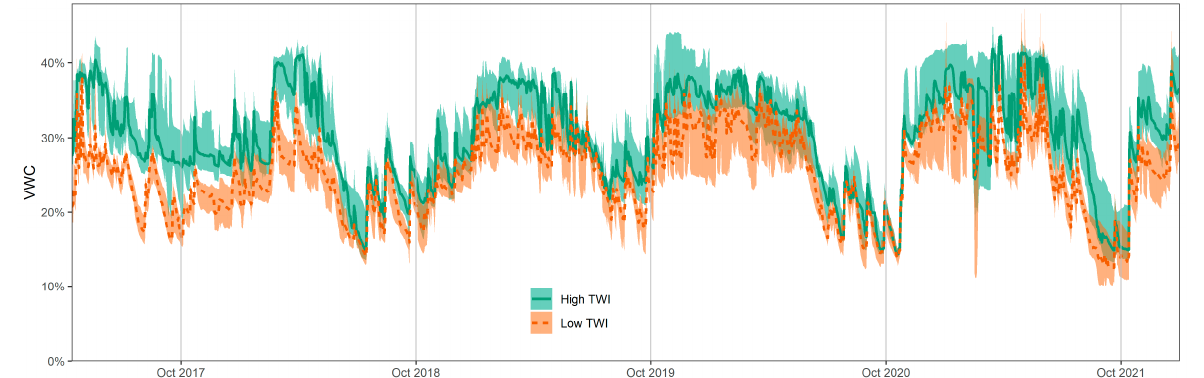
Figure 4. Daily median soil moisture values at 15 cm. Shaded regions represent the 25th and 75th percentile soil moisture values and illustrate spatial variability at each timestep. Green line represents the median value of VWC for the sensors in locations with TWI values greater than 7.4; Orange dashed line represents the median VWC for the sensors in locations with TWI values less than 7.4 (using D8 algorithm) [14].